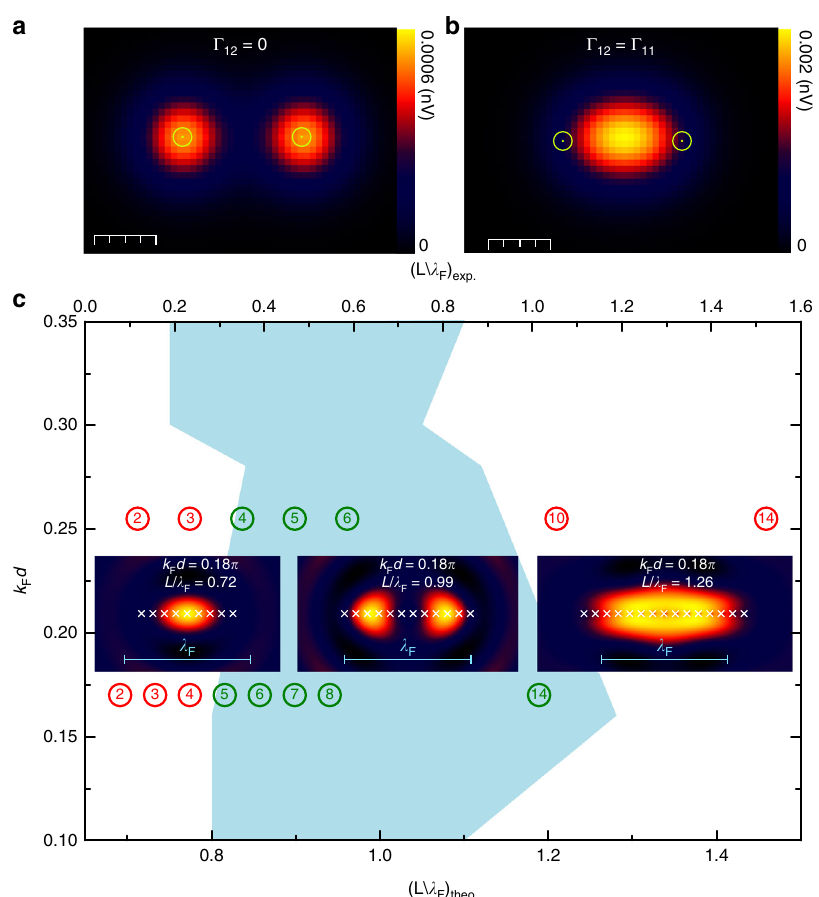
Fig. 5 Spectral function maps of the MIAM in the Kondo regime. a , b Theoretical map of the impurities ’ spectral function evaluated at the energy of the Kondo peak of a dimer with spacing d = 2.6 a = 7.5 Å. Scale bars represent 4 Å. The two fi gures ( a , b ) differ only in the off-diagonal element of the hybridization function ( Γ 11 = 10 meV, Γ 12 = 0 and Γ 11 = Γ 12 = 10 meV, respectively). The other model parameters are given in Methods. The impurities ’ positions are marked by yellow circles. c Diagram for the appearance of edge lobes in spectral function map of conduction electrons (see Methods, Γ 0 = 60 meV), constructed by analyzing chains of different spacing d and length L = ( N − 1) d . The pale blue area corresponds to the d − L region where edge lobes appear. Insets represent selected spectral function maps of chains with N = 9, 12, 15 atoms and spacing d = 2.2 a , exemplifying the presence or absence of edge lobes. The spectral function is again evaluated at the energy of the Kondo dip. The impurities ’ positions are marked by white crosses. The chain length for theoretical results is given in the bottom abscissa in units of λ F . Green(red) empty circles are experimental data points from A K maps with (without) edge lobes in chains as deduced from A K maps in Fig. 4 for d = 2 a and d = 3 a (the images of the chains not shown there are available in Supplementary Fig. 8). The number enclosed by the circles is the number of atoms, N . The experimental chain length is given in the upper